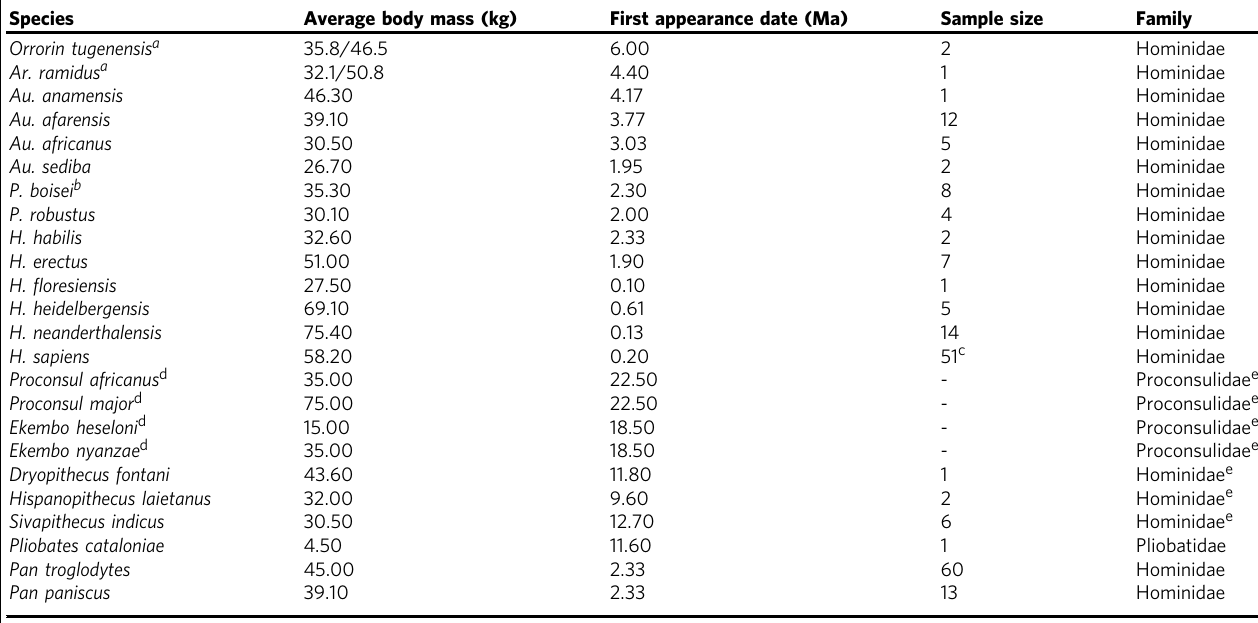
Table 1 Estimated body mass averages, fi rst appearance dates, sample sizes, and family designations for hominin and fossil taxa included in this analysis, along with comparative data for modern humans, Pan troglodytes , and Pan paniscus